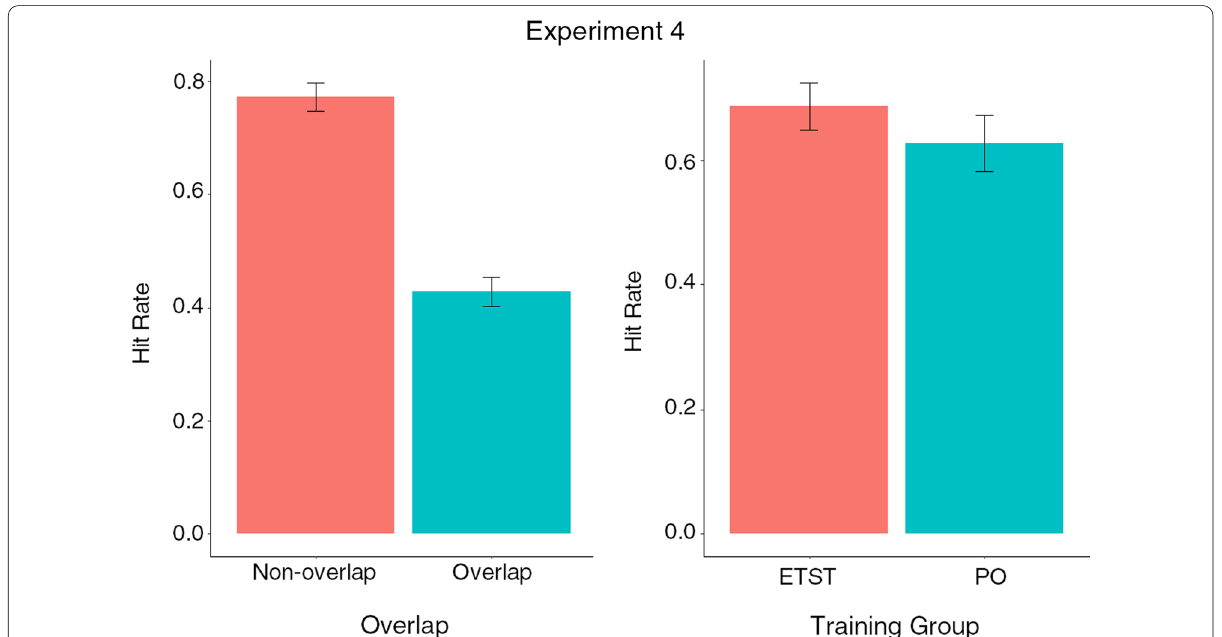
Fig. 12 Hit rate and false alarm rate by training group and overlap conditions corresponding to LMM analysis for Experiment 4 (enhanced targetless search training [ETST] and practice only [PO], error bars show 95%